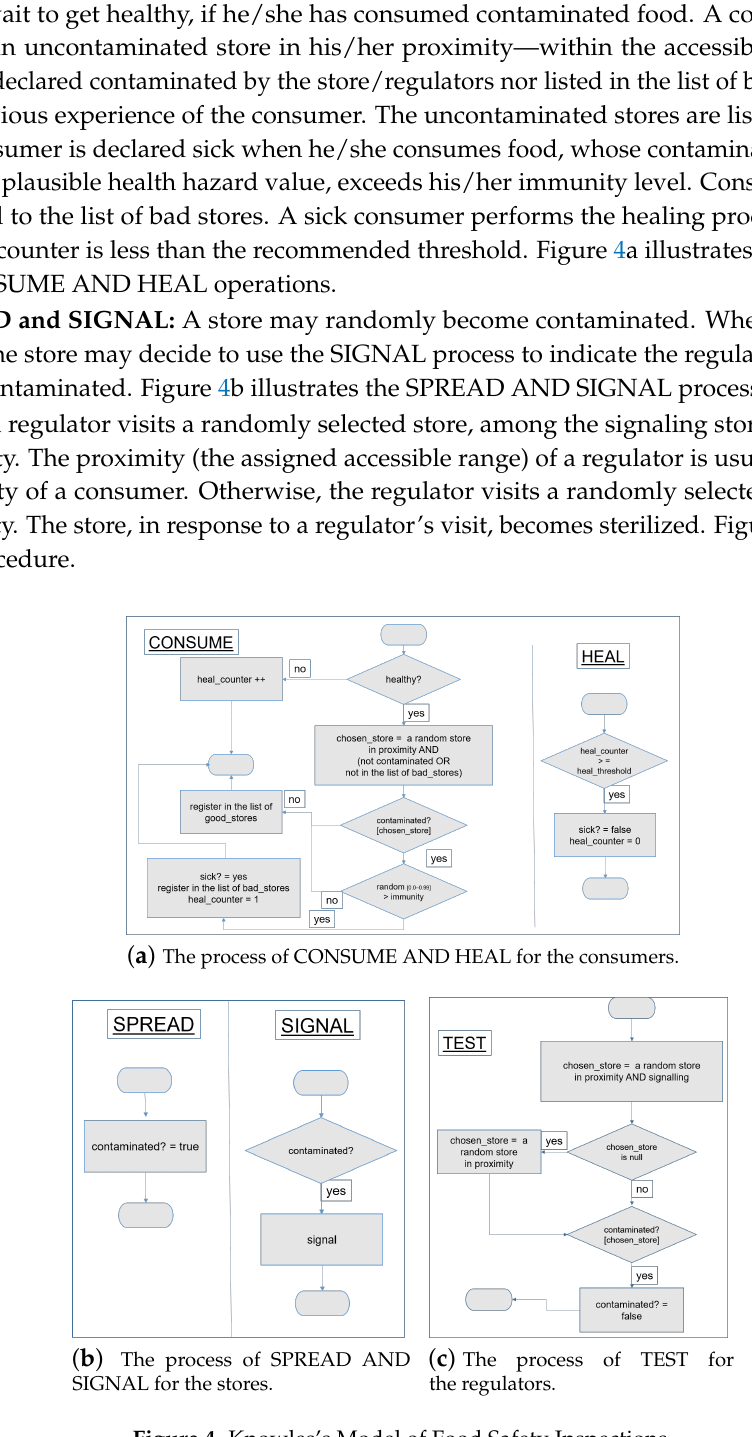
Figure 4. Knowles’s Model of Food Safety